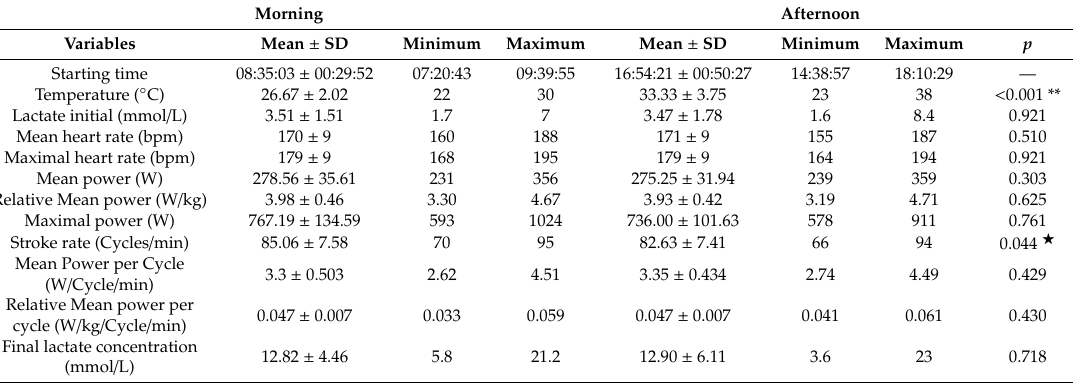
Table 2. Descriptive statistics (minimum, maximum, mean, and standard deviation (SD) values) values for the analyzed variables during the 20 min maximum protocol time trial on the mountain bike.